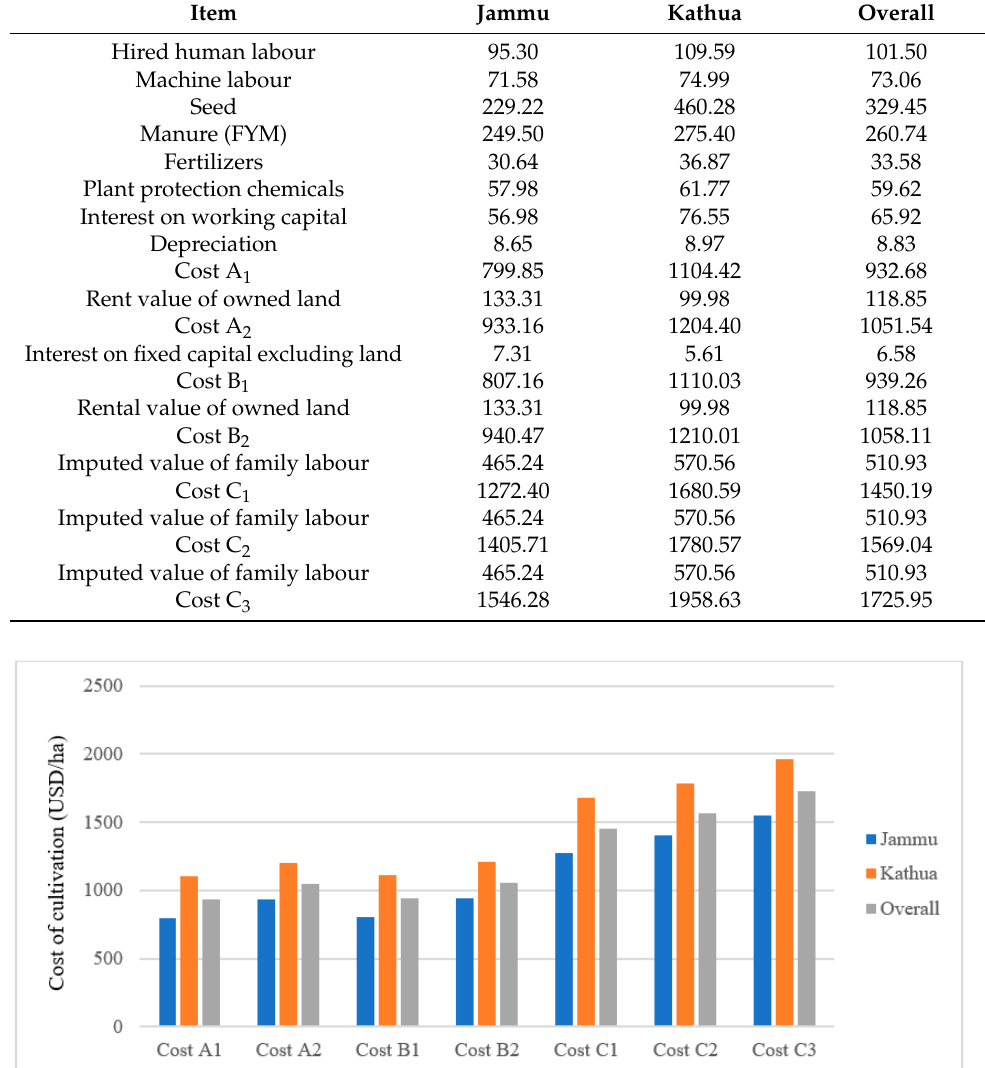
Figure 1. Operation-wise cost of cultivation of marigold (USD · ha − 1 ). Table 2. Concept-wise cost of cultivation of marigold cultivation (USD · ha − 1 ).